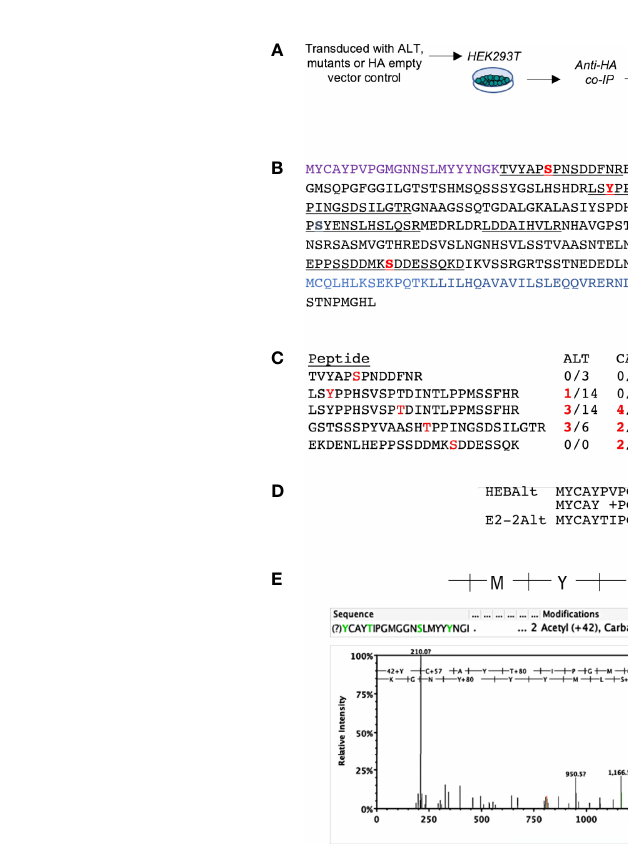
FIGURE 4 | Detection of post-translational modi fi cations in HEBCan, HEBAlt, and HEBAlt mutant proteins transfected into HEK293T cells. (A) Diagram of experimental design. HEK293T cells were transfected with HA-tagged constructs and subjected to immunoprecipitation 24 hrs later using anti-HA antibodies. Lysates were subjected to mass spectrometry sequencing, and sequences were analyzed to detect post-translational modi fi cations (PMTs). (B) Annotated amino acid sequence of HEBAlt. Purple = Alt domain. Underlined = peptides detected. Red = residues with S/T/Y phosphorylation detected at least once. Blue = bHLH domain. No peptides were detected representing the Alt domain. (C) Table showing the numbers and distribution of speci fi c PMTs in each peptide among samples bearing different constructs. LP = probability that the site of phosphorylation has been correctly annotated, as calculated by the Scaffold-PTM software. (D) Alignment of the Alt domains of HEB and its paralog E2-2 showing the two amino acid difference between them. (E) Spectrum of a peptide identi fi ed as E2-2Alt in the FFF sample with a mass shift of +80 at the last tyrosine of the YYY motif, consistent with